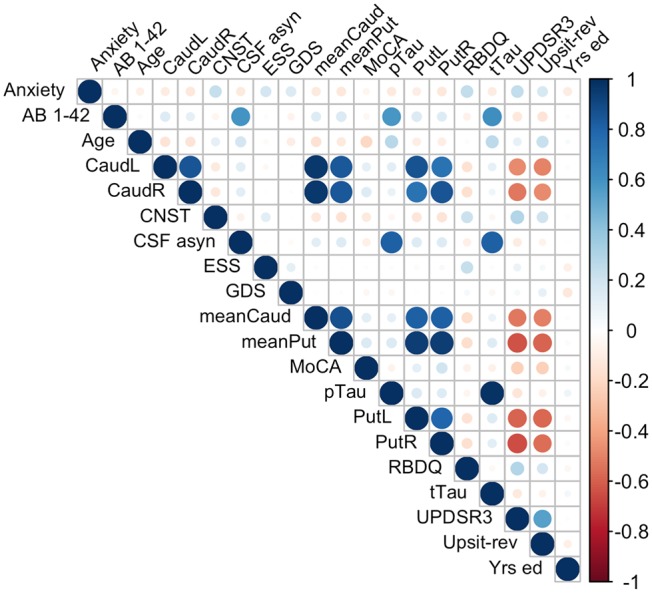
Predictor correlations (Spearman). Circle size is proportional to Spearman correlation; red indicates a negative correlation and blue a positive correlation; Anxiety, trait subscale from the State-Trait Anxiety Inventory; CNST, constipation based on MDS-UPDRS I; CaudL, left caudate; CaudR, right caudate; PutL, left putamen; PutR, right putamen; meanCaud, left + right caudate /2; meanPut, left + right putamen /2; UPDRS3, MDS-UPDRS III; Upsit-rev (hyposmia), University of Pennsylvania Smell Identification Test (a reverse scaled version); AB 1-42, beta-amyloid1-42; CSF a-syn, cerebral spinal fluid α-synuclein; pTau, CSF phosphorylated Tau; tTau, CSF total tau; MoCA, Montreal Cognitive Assessment; Yrs. ed., years of education. Note, CaudL, CaudR, PutL, PutR are dopamine transporter (DAT) DAT scan measures.